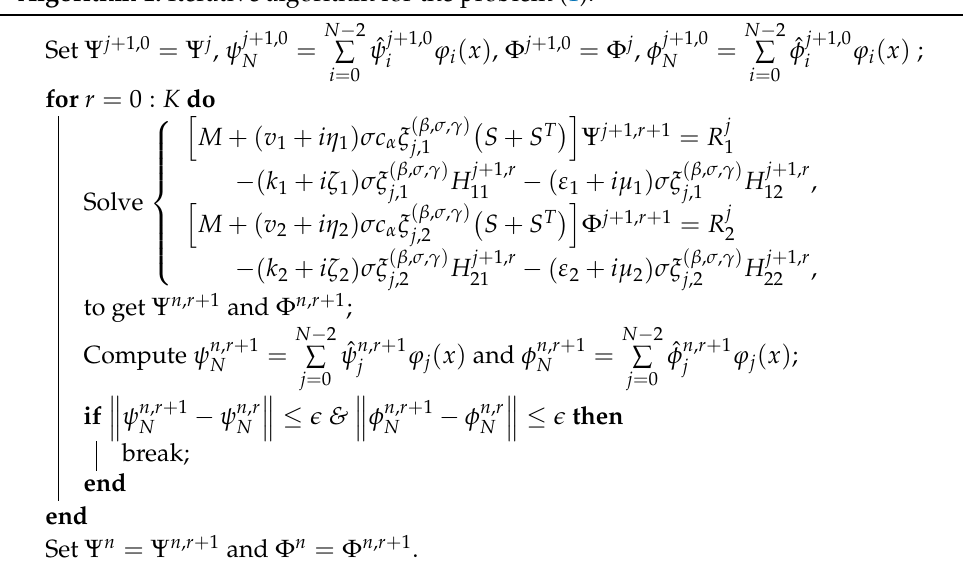
Algorithm 1: Iterative algorithm for the problem